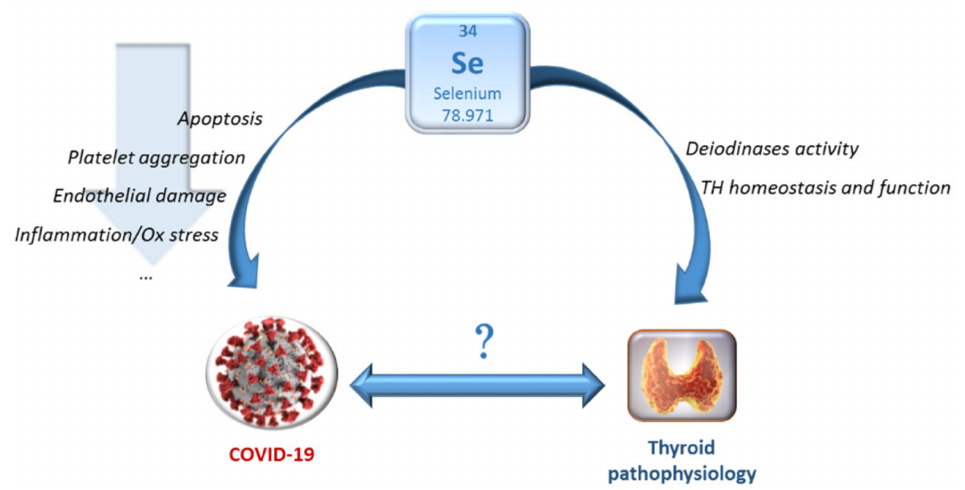
Figure 3. Selenium, Sars-CoV-2 and thyroid gland interconnection. Preliminary data suggest a possible bidirectional relationship between COVID-19 and thyroid dysfunction, and both conditions seem to be associated with Se deficiency (see text). Whether Se supplementation may modulate the relationship between SARS-CoV-2 infection and thyroid pathophysiology remains to be clarified in further studies. Abbreviation: TH—thyroid